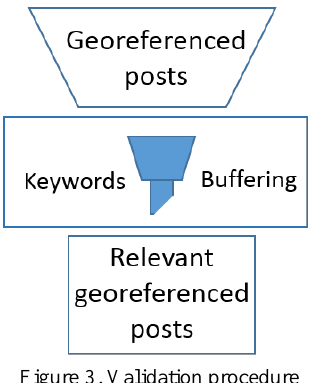
Figure 3. Validation